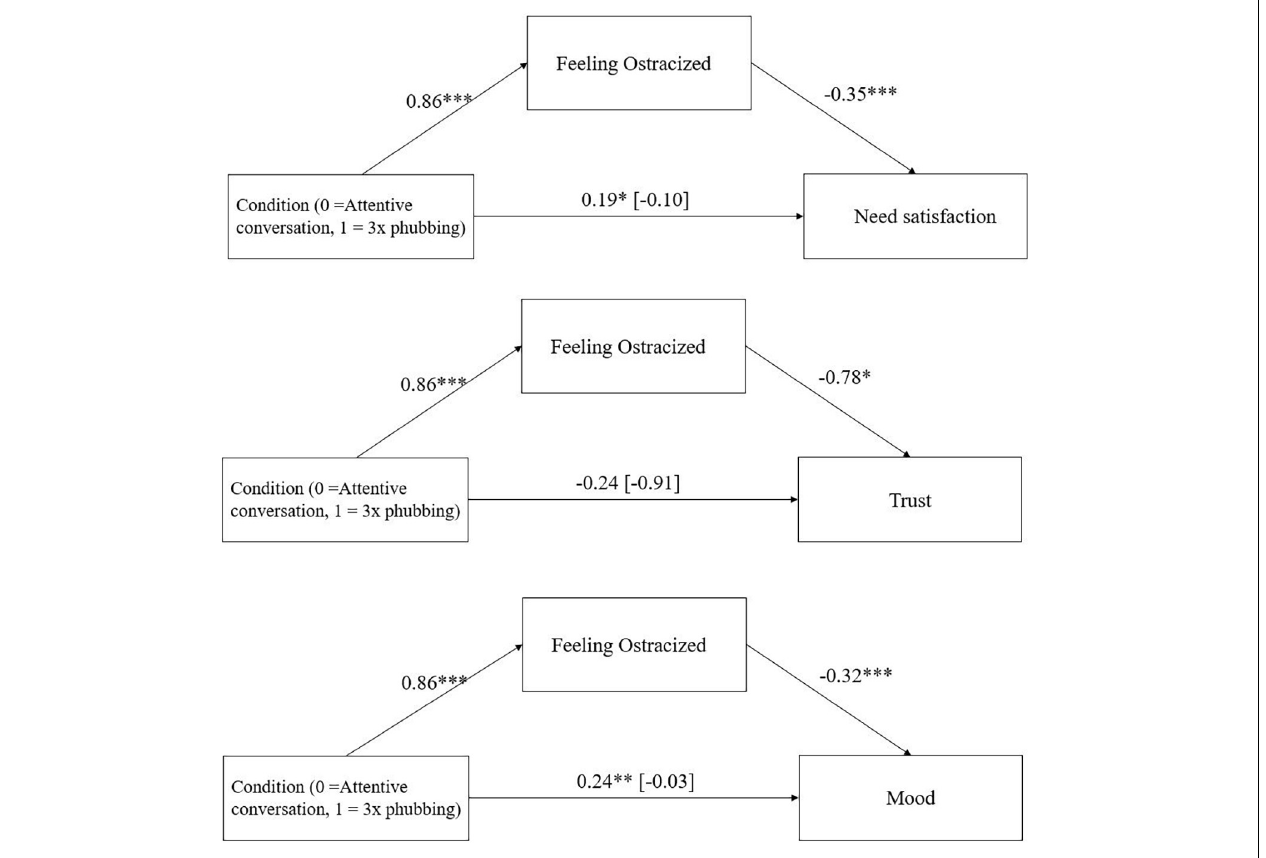
FIGURE 5 | Mediation effect of condition (attentive conversation vs. 3x phubbing) via feelings of ostracism on need satisfaction, trust in the trust game, and mood in Study 2 including the direct effect of condition on need satisfaction and mood (with total effect in parentheses). ∗ p < 0.05, ∗∗ p < 0.01, ∗∗∗ p <